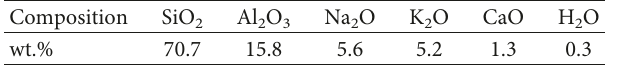
Table 1: Chemical composition of